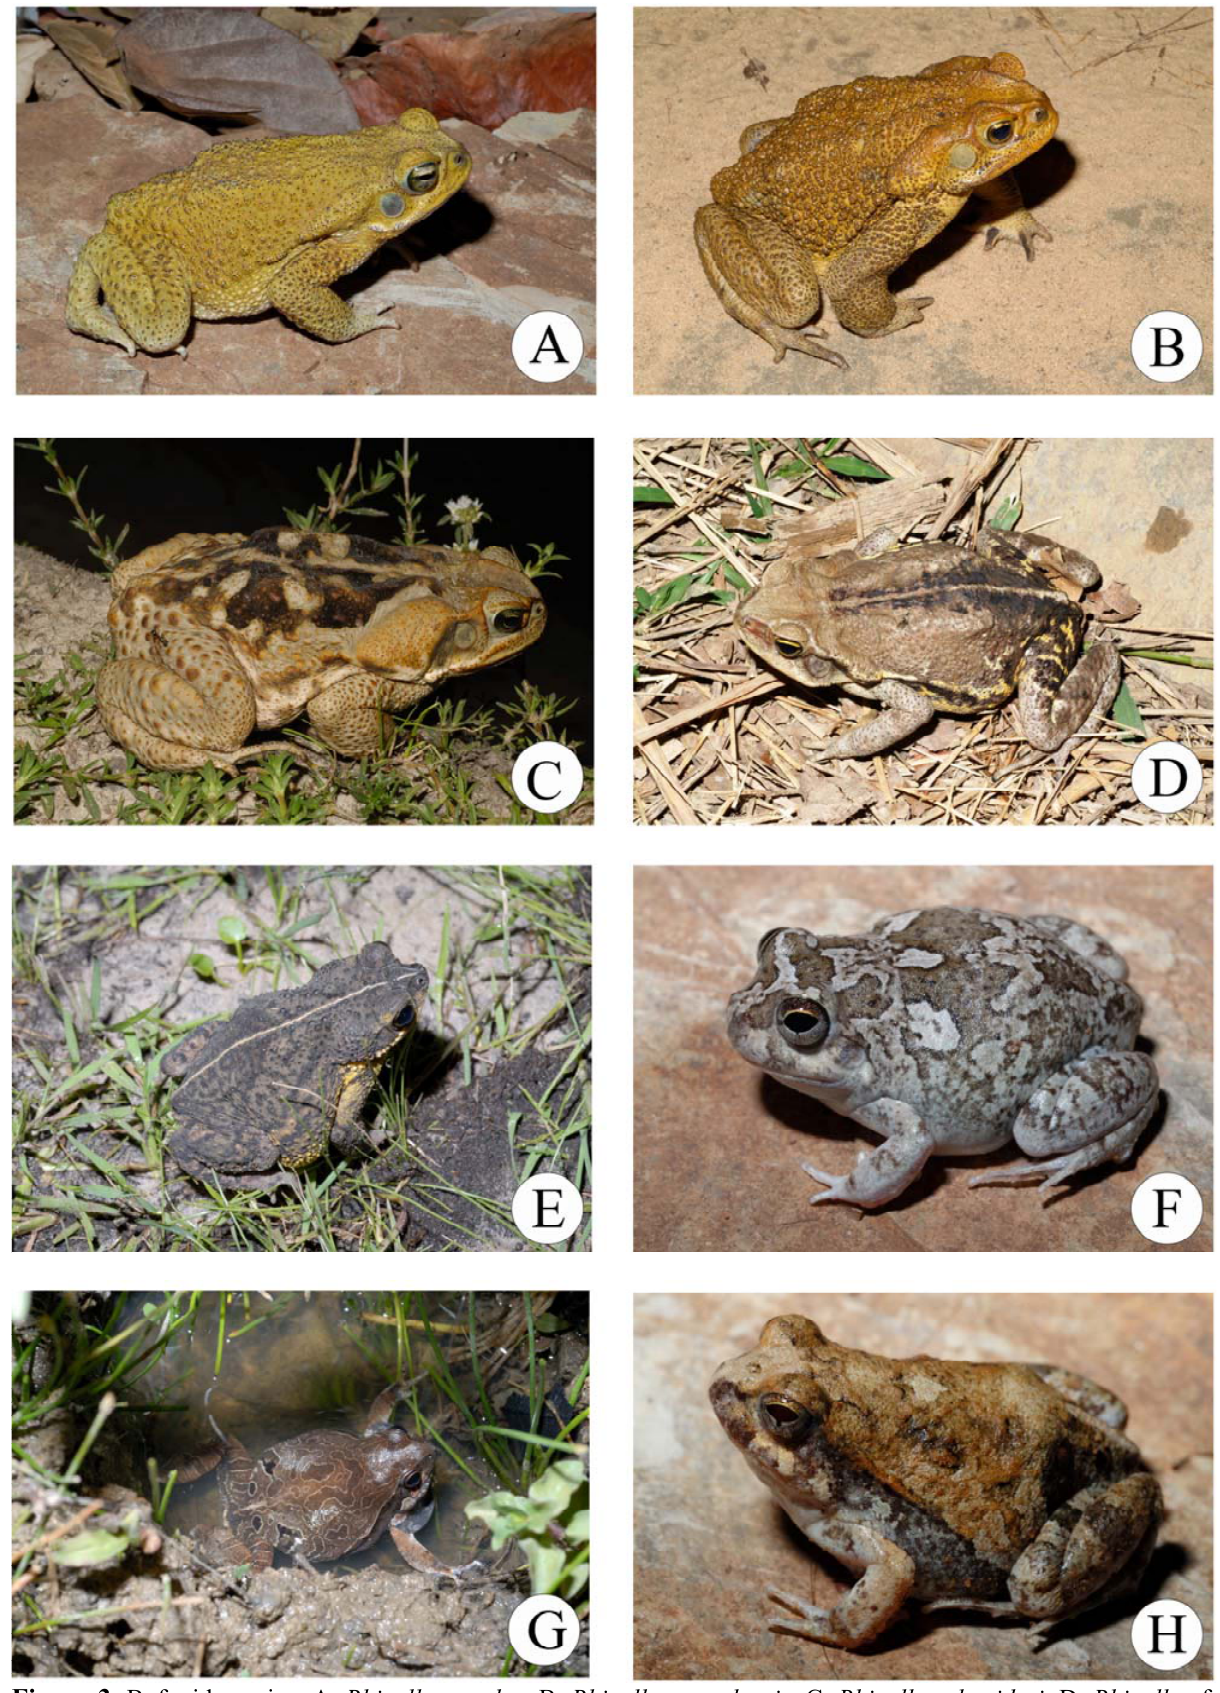
Figure 3. Bufonid species: A. Rhinella veredas ; B. Rhinella cerradensis ; C. Rhinella schneideri ; D. Rhinella cf. pombali ; E. Rhinella mirandaribeiroi ; Leiuperid species: F. Pleurodema diplolister ; G. Physalaemus centralis ; H. Physalaemus albifrons ; collected in the municipality of São Desidério, state of Bahia. Photo: P. H.